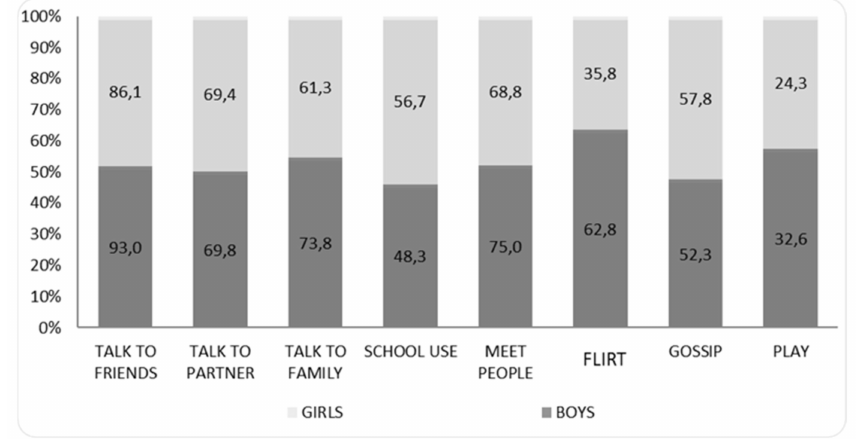
Figure 1. Use of social networks according to sex. Results come from responses to the question: ‘What do you use social networks for?’. This information is confirmed in the analysis of the discourses of the population studied, which manifests this difference in the motivation of the use of networks. Below we can see some expressions (Table